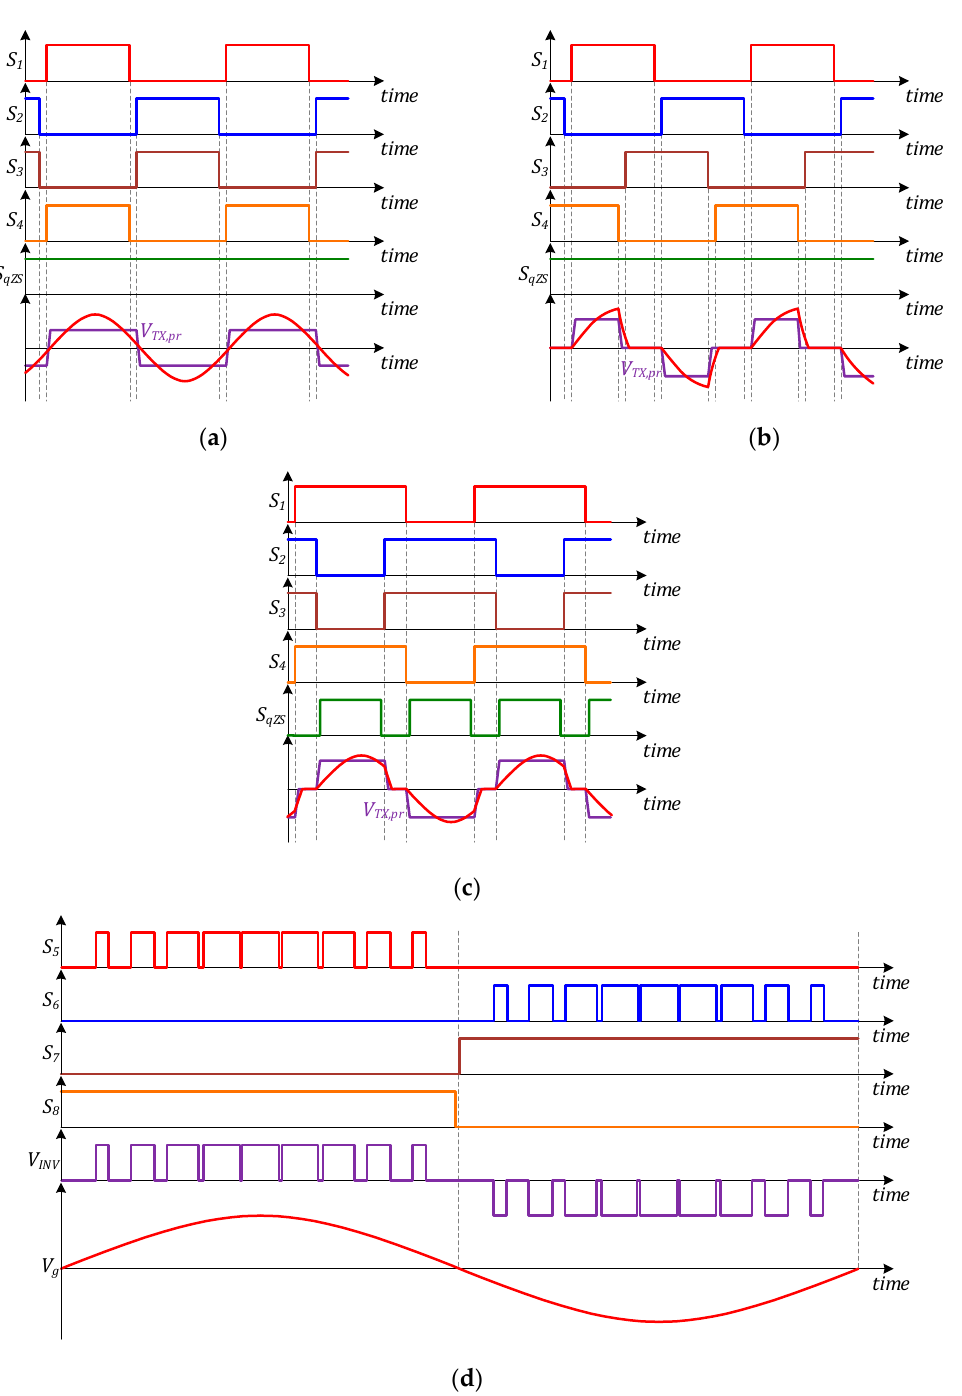
Figure 5. Modulation techniques of the front-end dc/dc converter operating in the pass-through. ( a ) buck, ( b ) boost, ( c ) modes, ( d ) asymmetrical unipolar modulation of the full bridge grid-tied